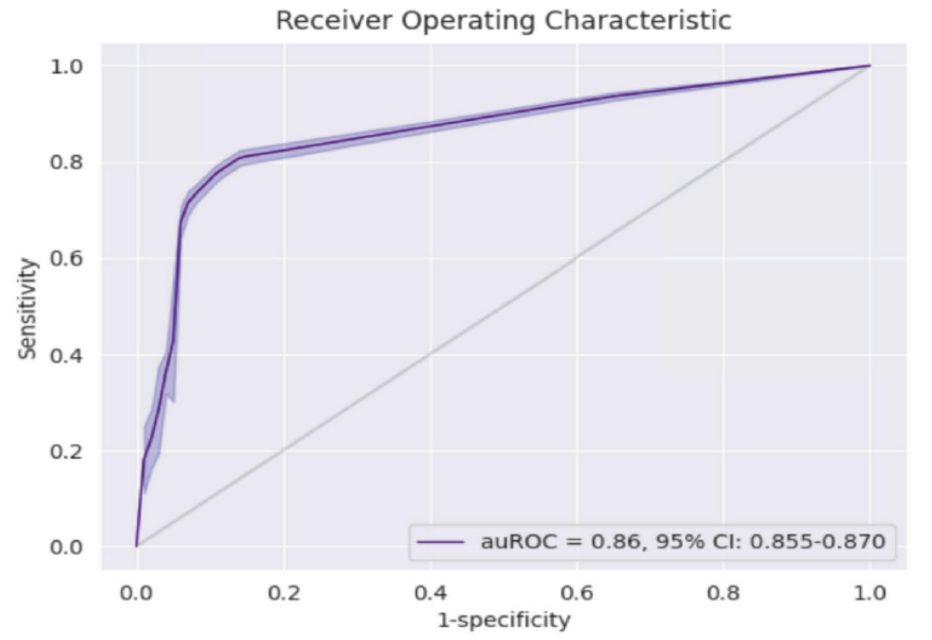
Figure 2. ROC curve showing model performance with high AUC of 86% [18].